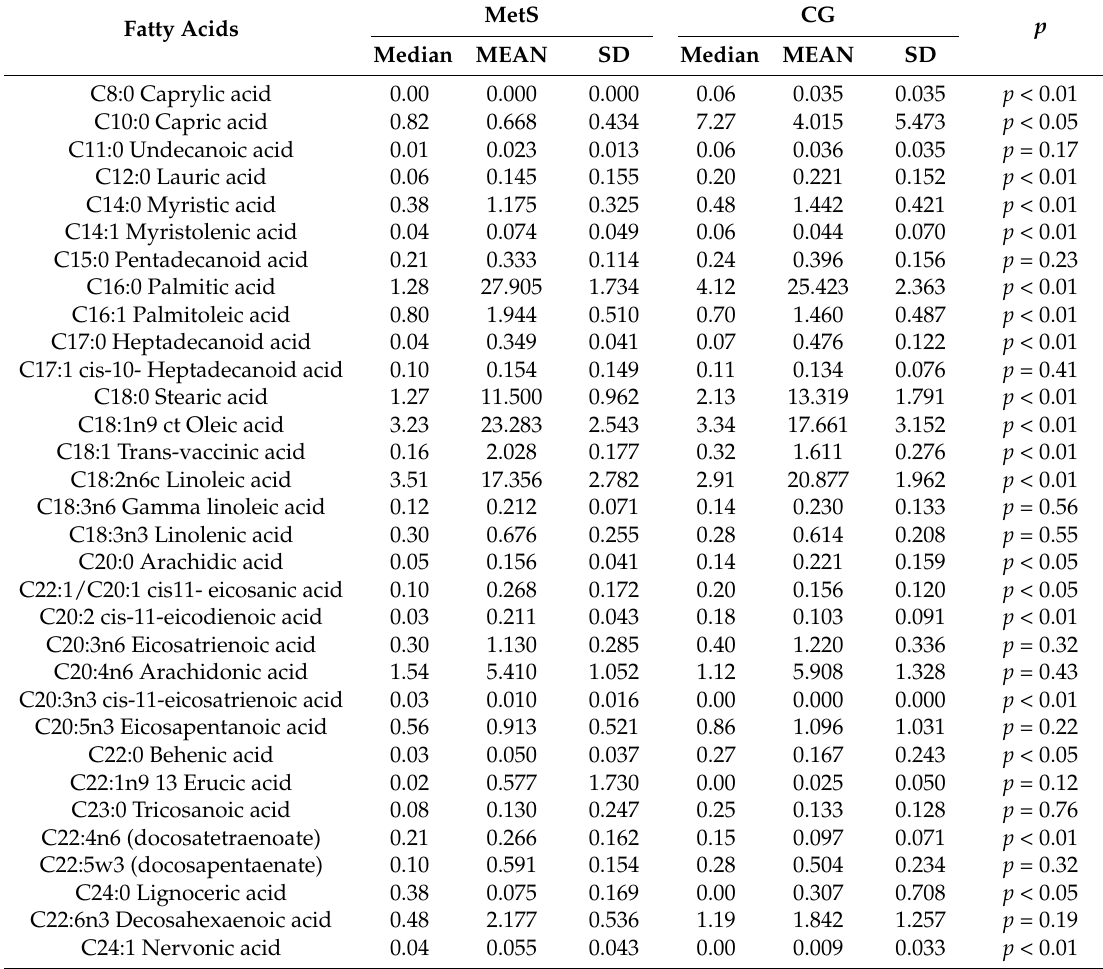
Table 1. Comparison of the contents of fatty acid (FA) in metabolic syndrome (MetS) vs. the control group (CG) [%]. EPA: eicosapentanoic acid. DHA: docosahexaenoic acid. Fatty Acids